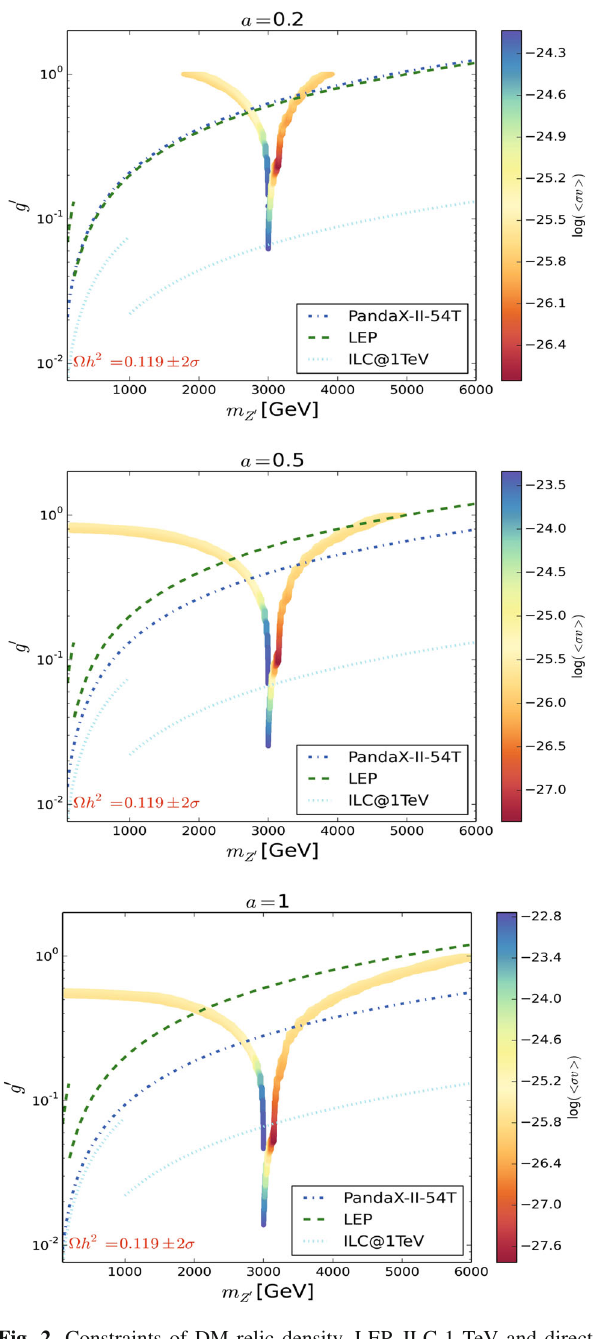
coupling g (cid:2) versus Z (cid:2) mass. The blue dash-dotted and green dashed curves are 90% C.L. upper limits of PandaX-II